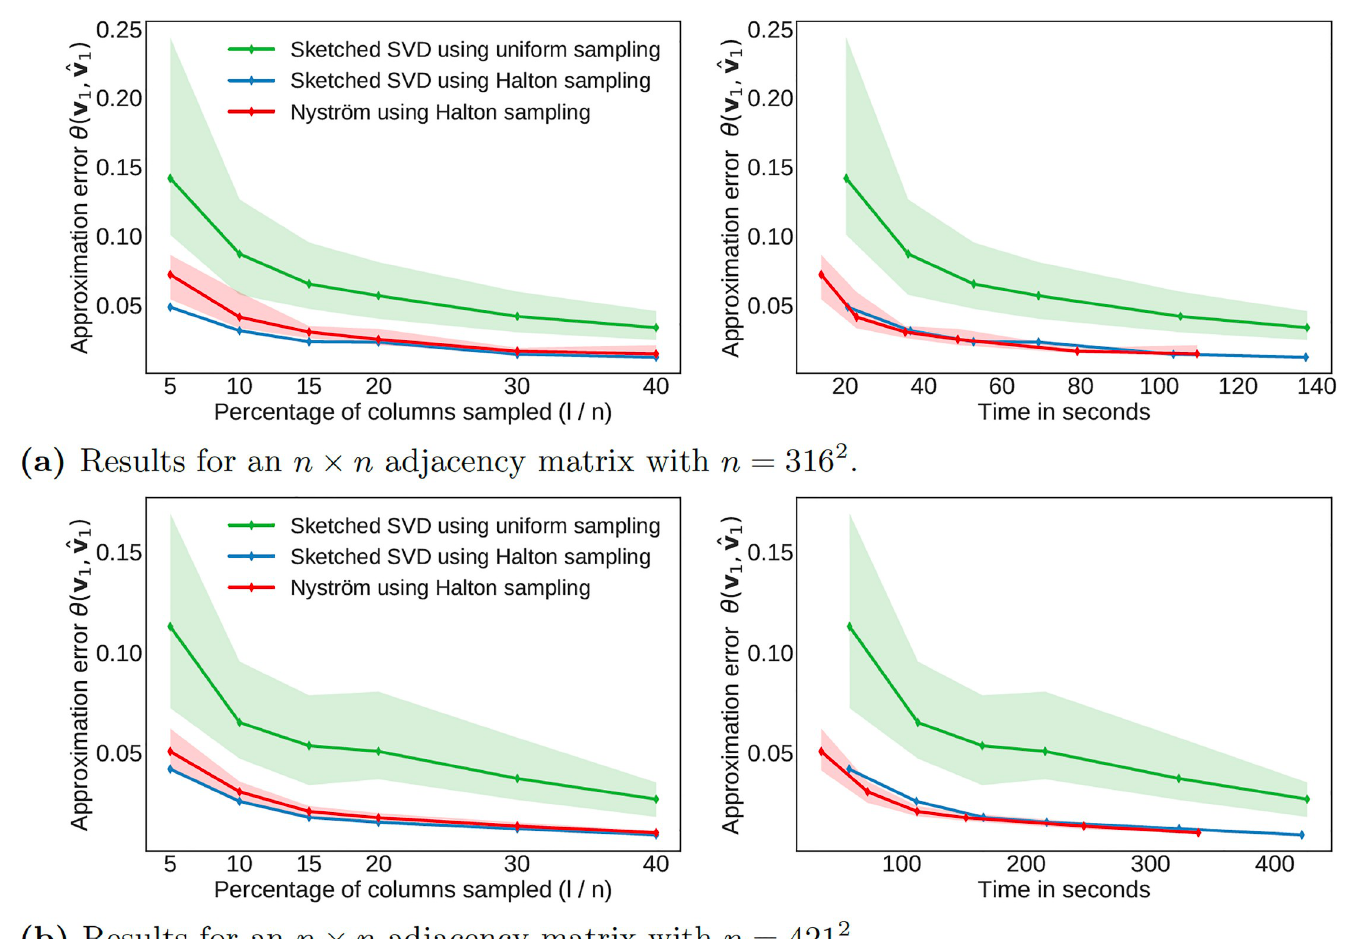
Fig 4. Computational performance for the flow over an airfoil using two different spatial resolutions. The results are averaged over 20 runs using different random seeds. The shaded region indicates the variance of approximation error in multiple runs.